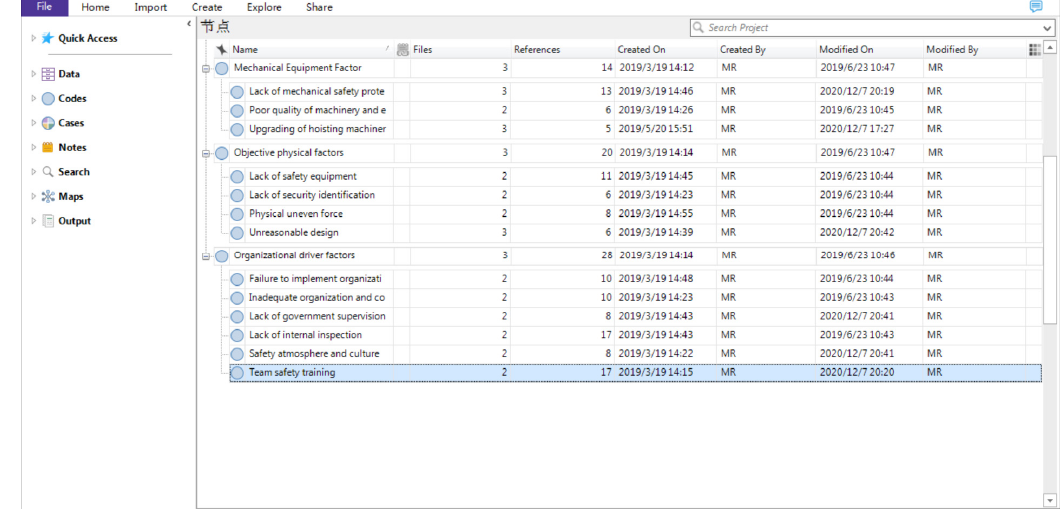
Figure 4. Selective coding results by using Nvivo12 (Part 2). The Chinese in the picture means